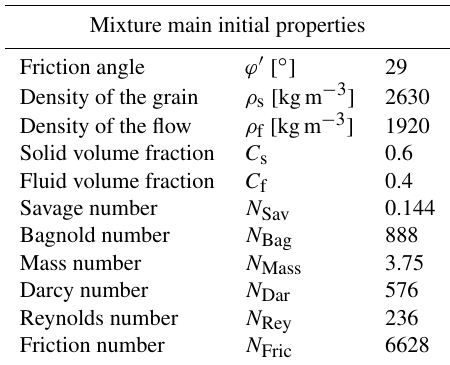
Figure 3. Grain size distribution of the